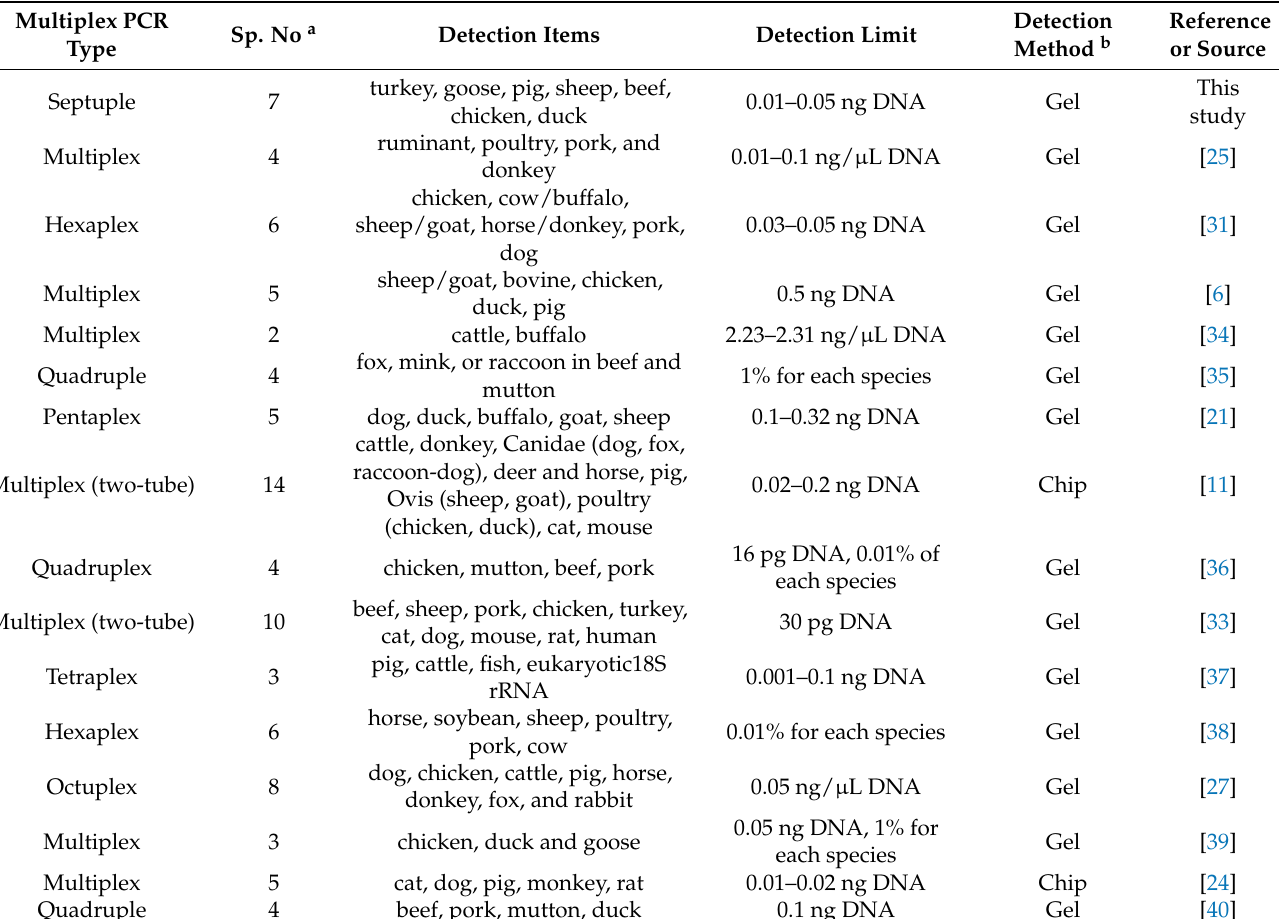
Table 3. Comparative analysis of recently published multiplex PCR assays for the identification of meat